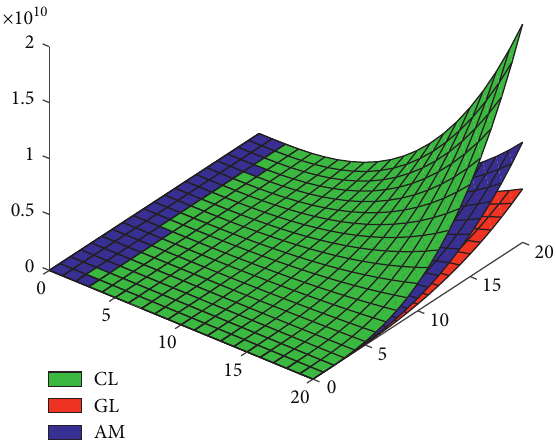
Figure 7: 3D graph of the M -polynomial of CL 15